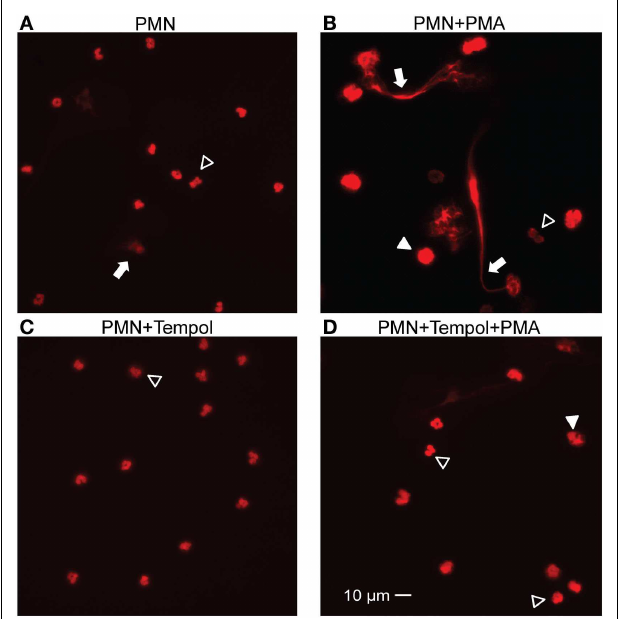
FIGURE 1 |Tempol reduces NET formation stimulated by PMA. Indirect immunofluorescence of PMA-stimulated PMNs (100nM) for 6h in the presence or absence ofTempol (30mM). Unstimulated PMNs and PMNs incubated withTempol only served as control. NET formation is visualized after fixation using staining of chromatin with a primary antibody directed against histone H1 and a Cy-3 conjugated secondary antibody.The representative microscopic images illustrate unstimulated PMNs (A) , PMNs stimulated with PMA (B) , PMNs treated withTempol (C) , and PMNs treated withTempol and stimulated with PMA (D) . NETs are indicated by arrows, decondensed nuclei with filled arrow heads. Open arrow heads show intact PMNs. Images were captured with a Nikon Eclipse 90i microscope and a Hamamatsu Orca-ER charge-coupled device camera using a 40× objective. Scale bar: 10 µ